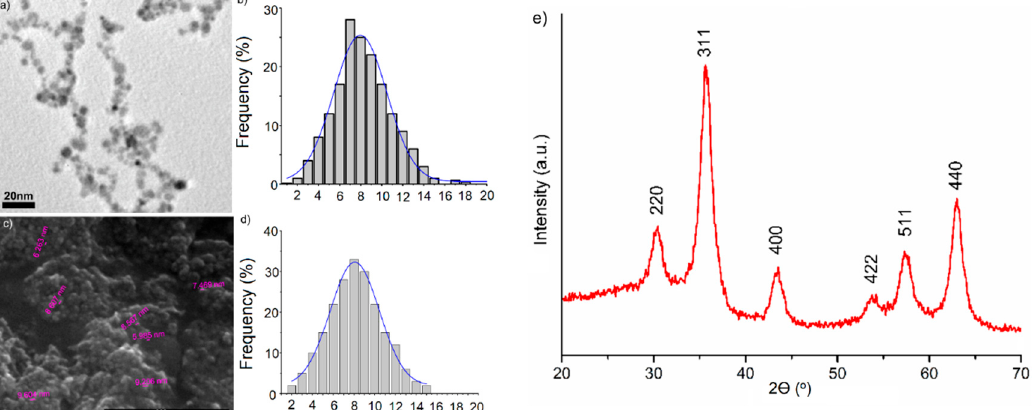
Figure 6. Large-area TEM ( a ), size distributions from TEM ( b ), SEM image ( c ) and size distributions from SEM ( d ) of iron oxide coated with dextran and X-ray diffraction pattern of dextran-coated maghemite nanoparticle (D-MNPs) ( e ).